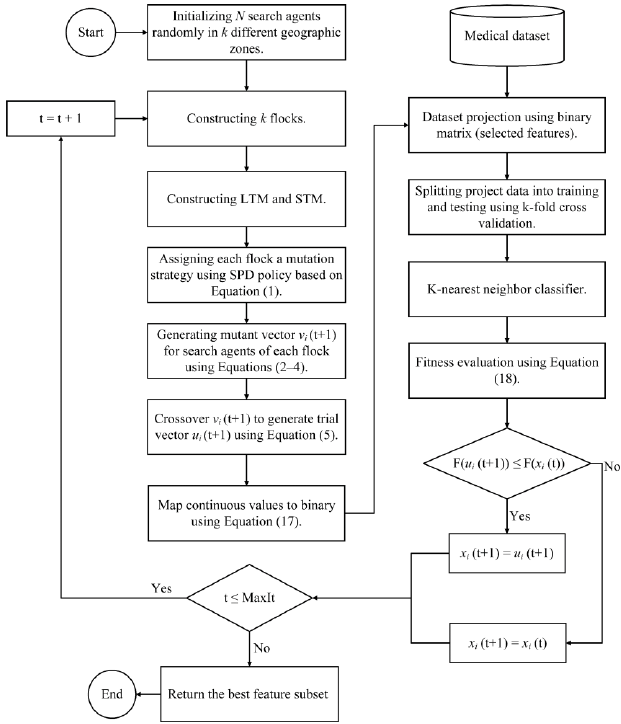
Figure 5. Flowchart of the proposed BQANA using a variable threshold.